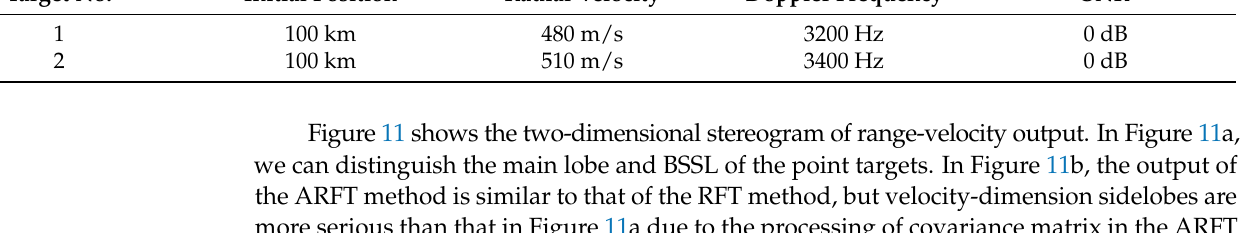
Table 5. Basic information of the targets set in Scenario 3.